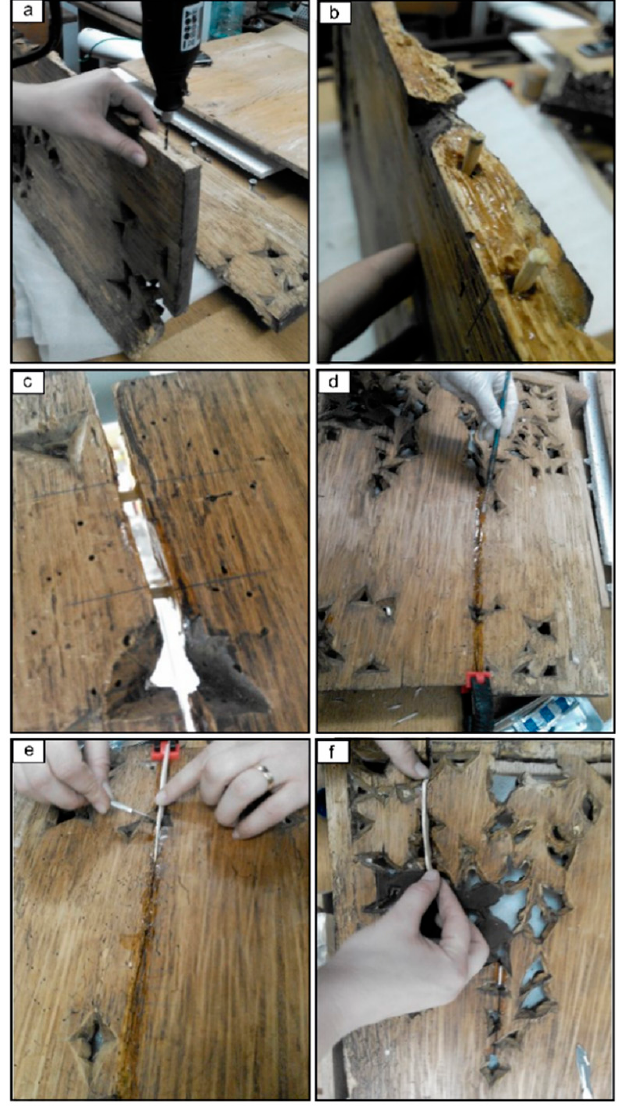
Figure 6. Aspects regarding the stages of reintegration and structural stabilization interventions: ( a ) Drilling holes for plugs; ( b ) Implanting the plugs in the soldered area of the two detached parts of the panel; ( c , d ) Fixing and gluing the two fractured fragments; ( e , f ) Application of balsa wood strips in the cracks areas before tightening into the vice.